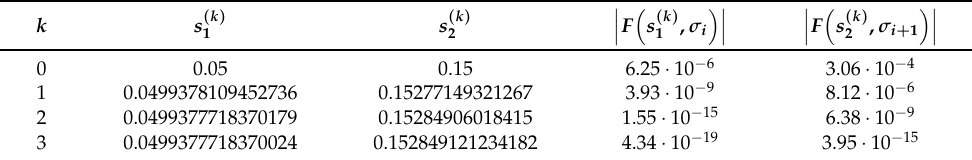
Table 2. Initial guess ( k = 0) and refinements of external integration domain splitting points along with the corresponding residual values for a parabolic curve parametrized by C ( s ) = ( s , s 2 ) , e i = [ 0,0.2 ] , ∆ hk =